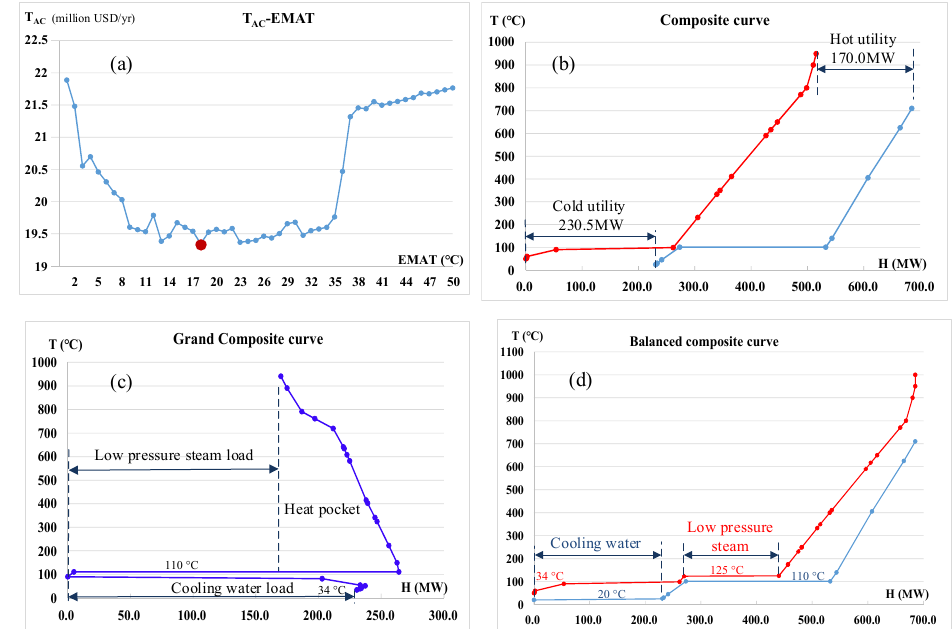
Figure 3. ( a ) TAC vs. ∆ T min , ( b ) cold and hot composite curves, ( c ) grand composite curve, and ( d ) balanced composite curve of CLHG+COMB. (Note: in figures ( b , d ), red line represents hot compound curve; blue line represents cold compound curve.). According to Figure 4a, the cold flow C11 absorbed a large amount of latent heat of vaporization during heating from cold water to superheated steam and the target temper- ature of 710 °C was achieved. Based on this feature, the high-temperature hot streams exchanged heat with C11 and the latent heat of vaporization required by C11 were pro- vided by low-pressure steam; thus, hot utilities at high temperature and reduction of op- eration costs were not required. The position of the pinch point can be seen in Figure 4a. The HEN required 175.22 MW of low-pressure steam and 235.76 MW of cooling water.